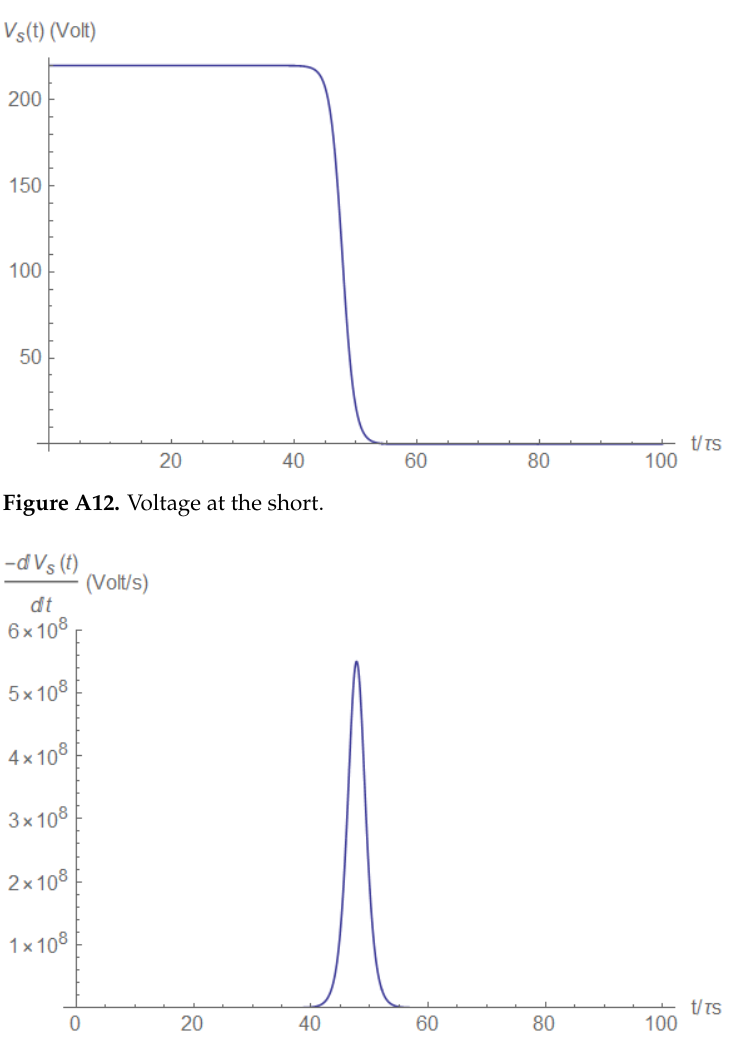
Figure A11. Voltage derivative at half the distance between the source and the short. The voltage at the short vanishes (Figure A12), since the resistance approaches zero during the short’s creation, providing the same behavior, which allows the pulse form in the voltage derivative (Figure A13).